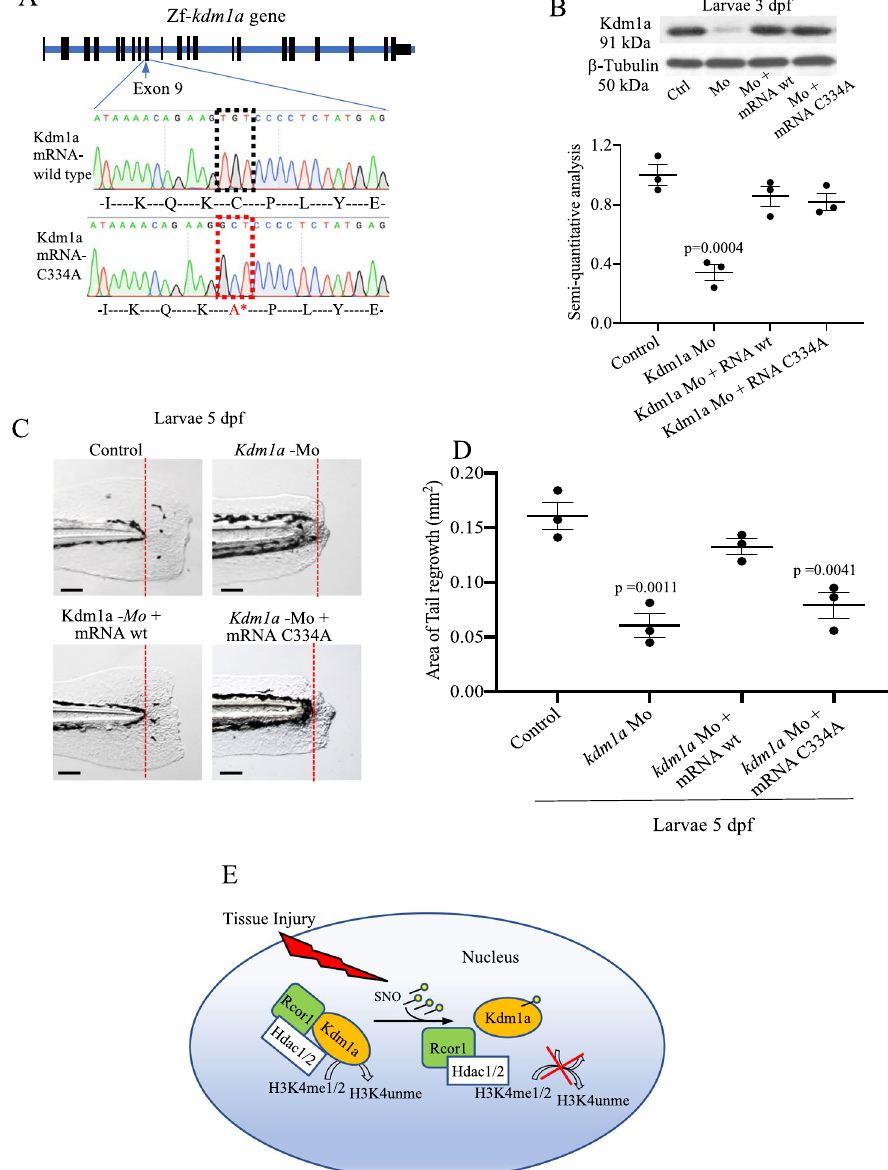
Fig. 6 Modulation of Kdm1a S-nitrosylation during tail fi n regeneration. A Kdm1a mRNA C334A was generated by site-directed mutagenesis, replacing the aa Cys334 with Ala. B – D Zebra fi sh embryos injected with kdm1a morpholino (Mo), or co-injected with kdm1a Mo with kdm1a mRNA C334A or wild type. B Western blotting and semi-quantitative analysis showed the effective knockdown and rescue of kdm1a following the different treatments. β -tubulin was used as loading control. C , D Images and dot plot of tail fi n regeneration following kdm1a modulation ( p values vs. control). Scale bar measures 100 μ m. E Working model. Tissue injury promotes the S-nitrosylation of the Cys334 of Kdm1a. S-nitrosylated Kdm1a detaches from the CoRest complex and loses its demethylase activity on H3K4. One-way ANOVA followed by Bonferroni ’ s multiple comparisons test, p values indicate comparisons vs. control. N = 3 biological replicates. Data are presented as mean values + / −